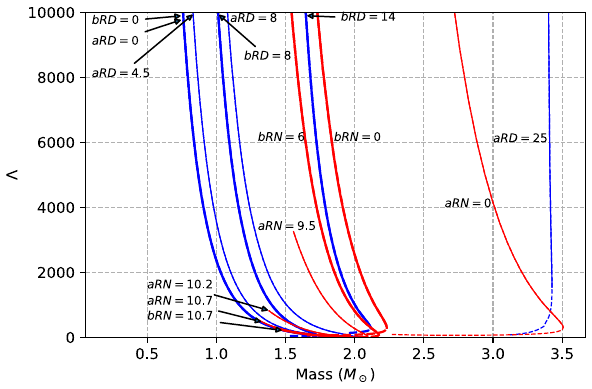
Fig. 6 Corresponding TLN–mass relations of Fig. 3. Similarly, the unstable configurations are indicated by the parts of dashed lines